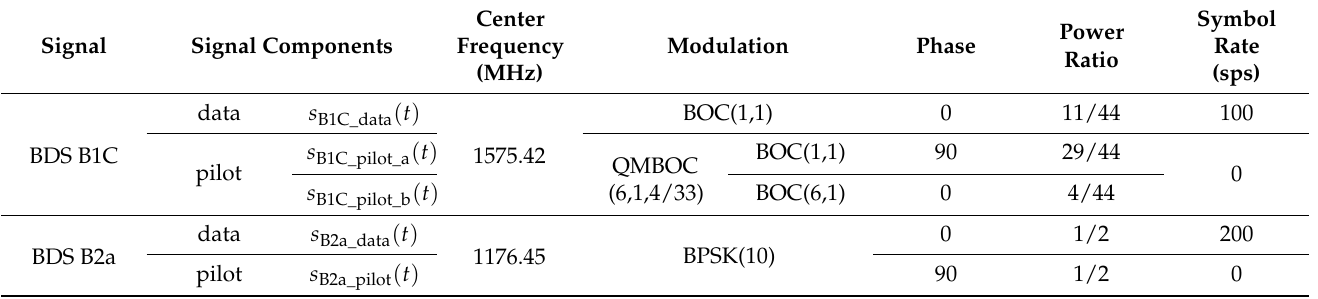
Table 1. The structures and modulation characteristics of BDS B1C and B2a